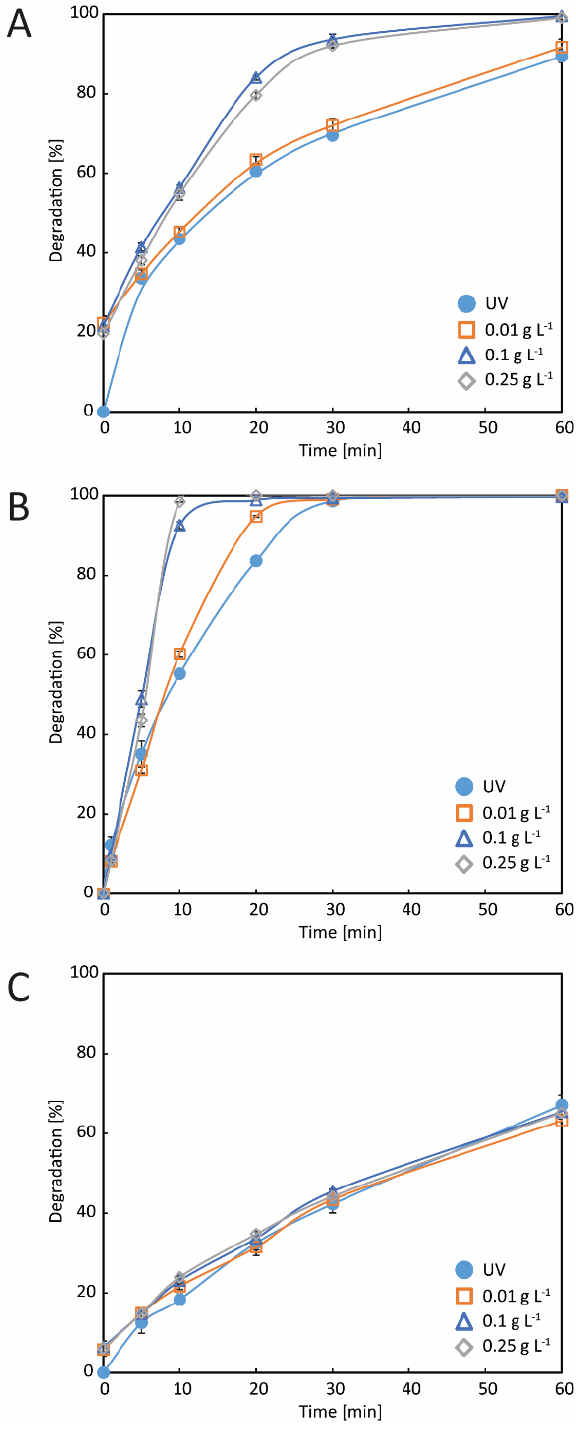
Figure 4. Removal of tested compounds during photodegradation with Ag-TiO 2 . ( A ) Degradation of BPA, ( B ) degradation of BPS, ( C ) degradation of FLC. The initial concentrations of BPA, BPS, and FLC were 10 mg L −1 .